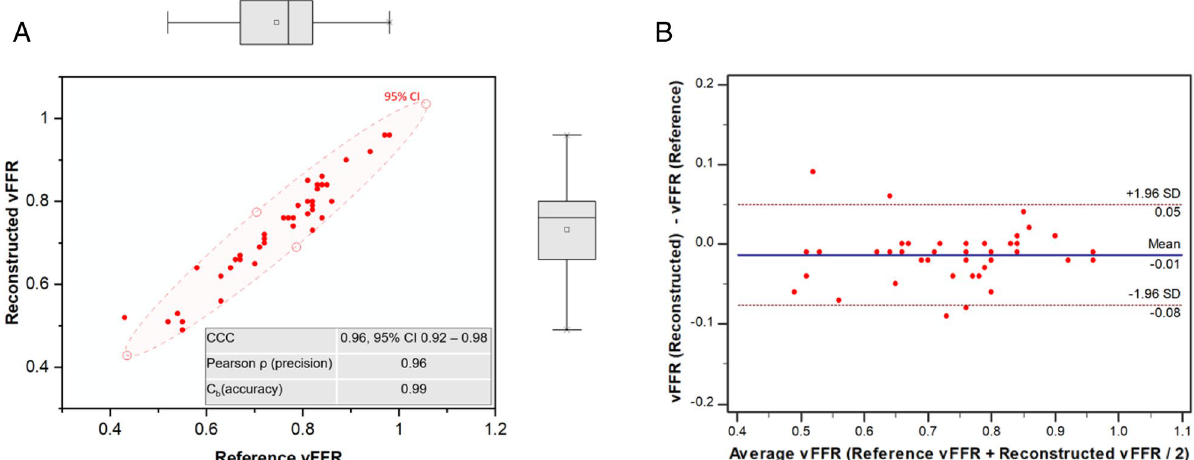
Figure 3. ( A ) Scatter plot demonstrating high concordance correlation coefficient (CCC) between between angiography-derived vFFR from the 3D reconstruction method and the gold-standard reference file-derived vFFR. ( B ) Bland–Altman Plot demonstrating agreement and differences between angiography-derived vFFR from the 3D CA reconstruction method and the gold-standard reference file-derived vFFR. Mean delta (bias) is shown as a solid line (− 0.01) and the upper and lower limits of agreement (SD: ± 1.96) are shown with the interrupted line (− 0.07 to +